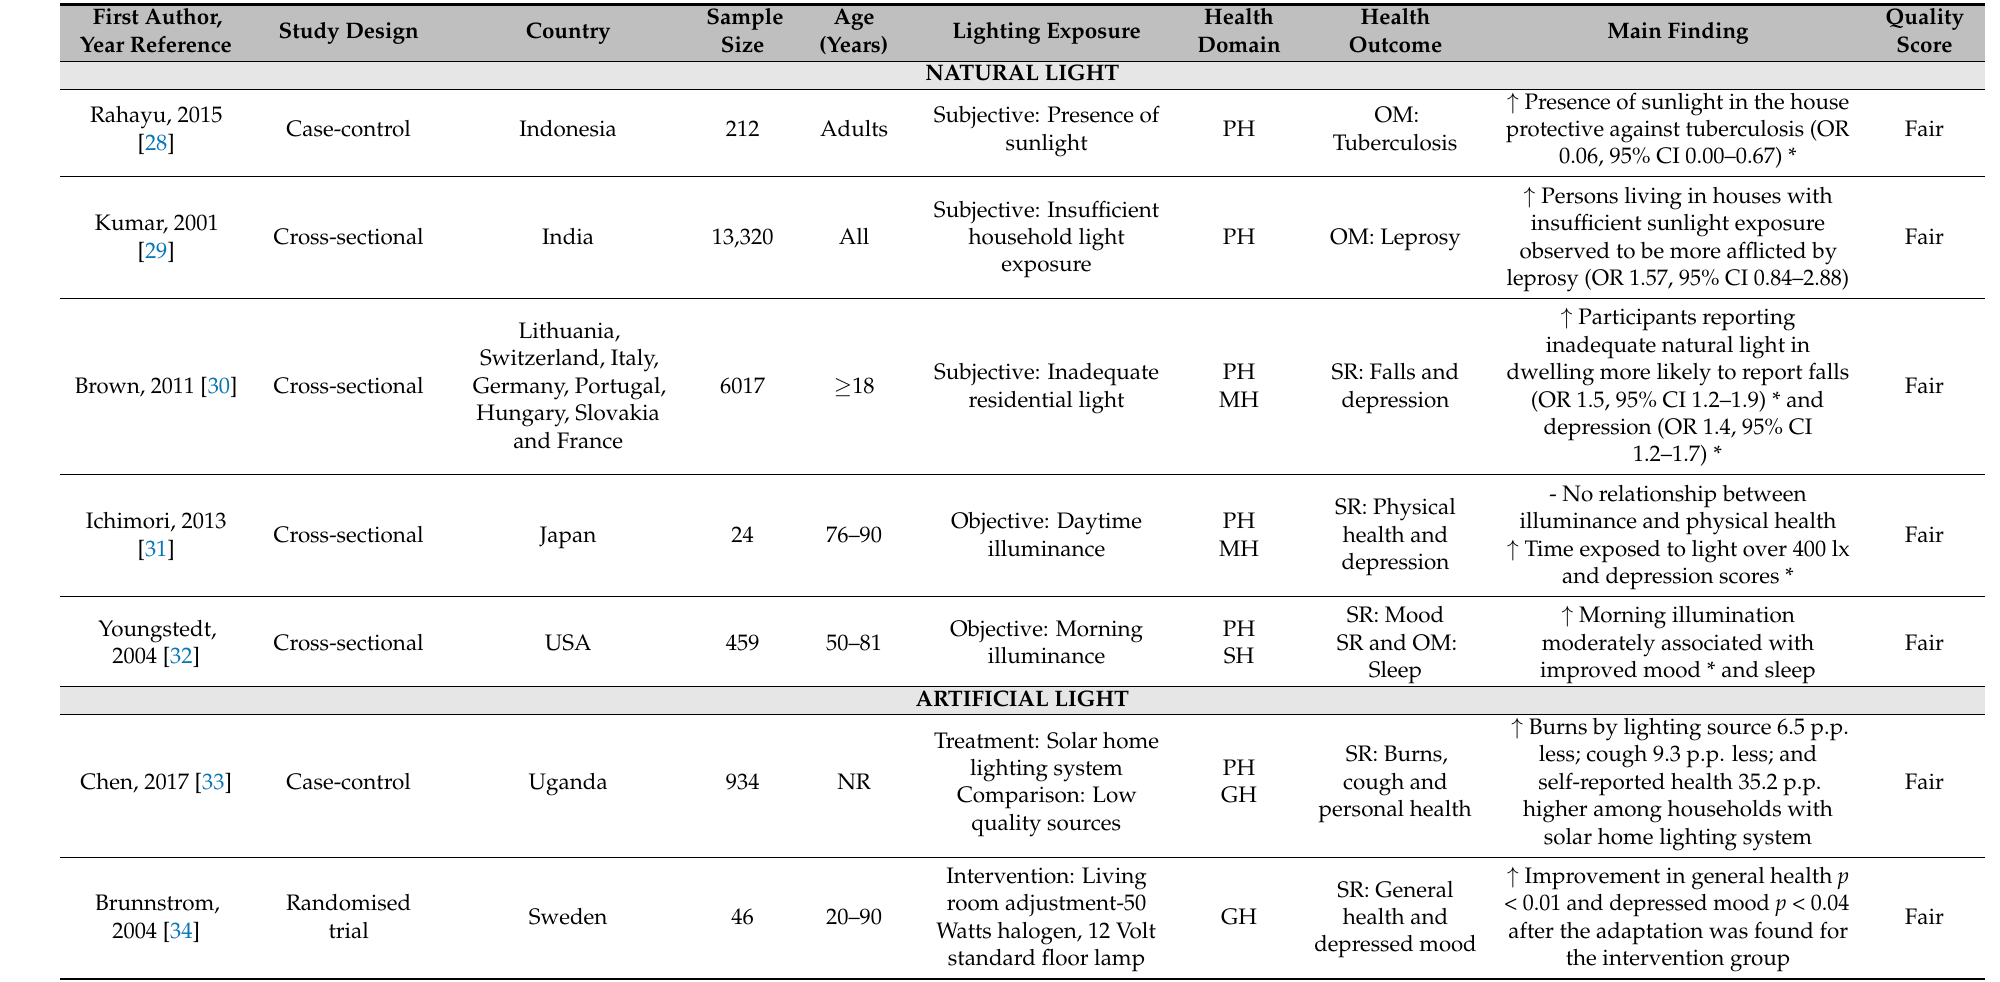
Table 1. Key characteristics of studies included in the systematic